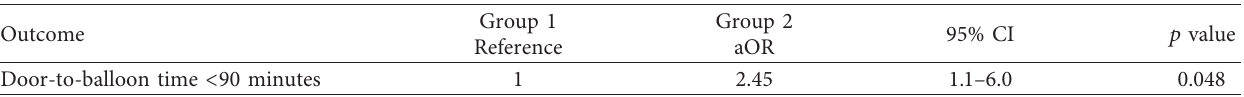
Table 3: The association between groups 1 and 2 and door-to-balloon time less than 90 minutes by logistic regression analysis.